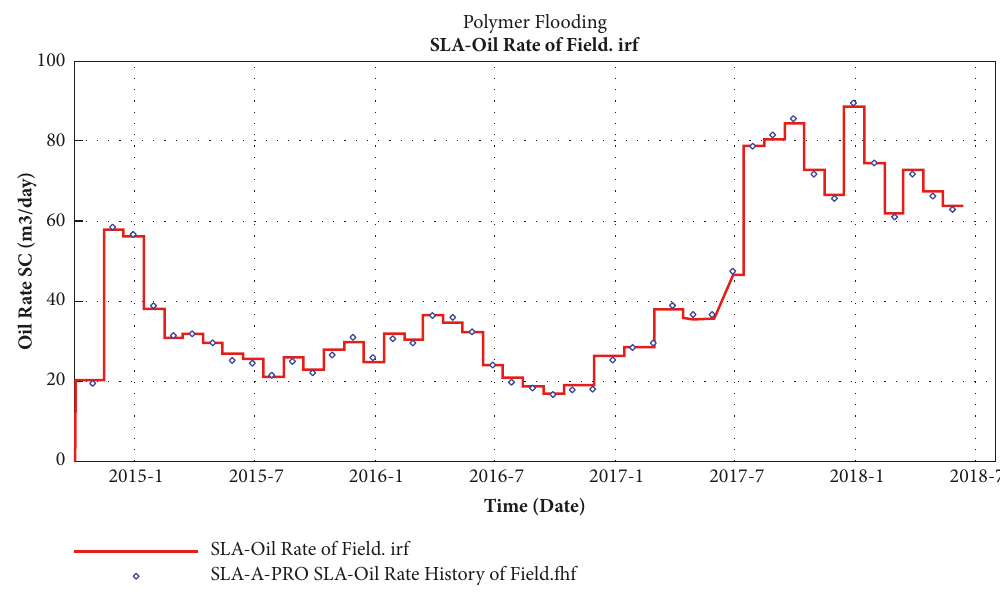
Figure 13: SL-A block daily oil production